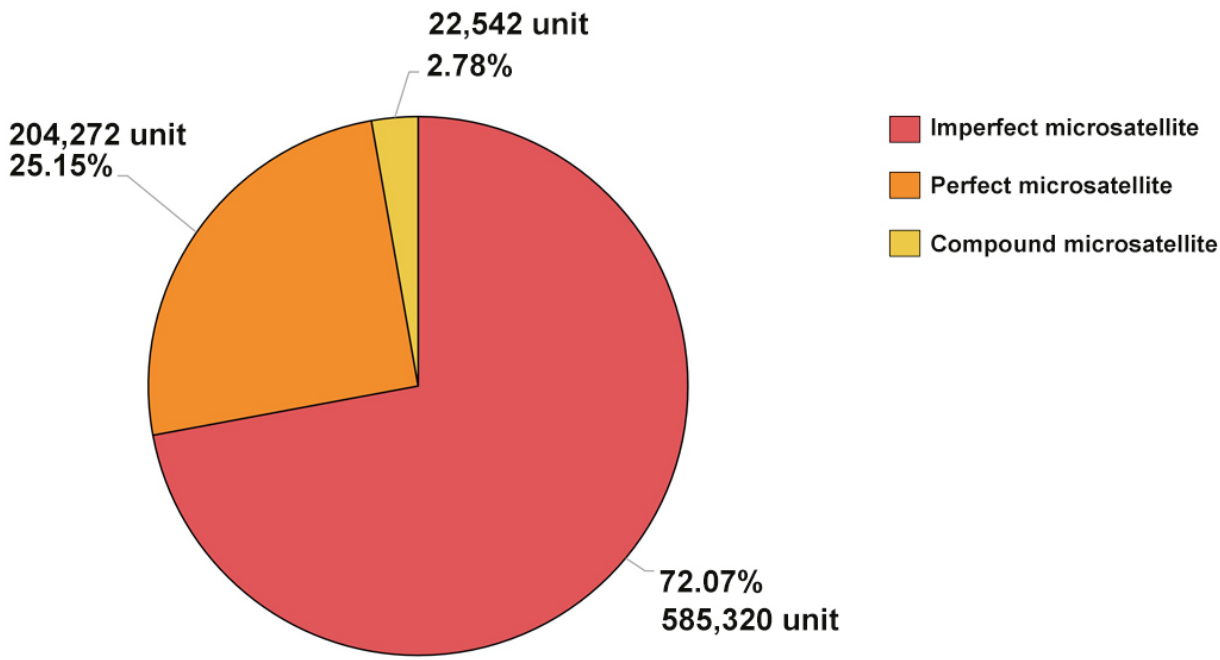
Figure 1. Pie diagram showing the portion of each microsatellite type in the Siamese fighting fish genome ( Betta splendens , Regan, 1910) [2] (Tables S3–S5).